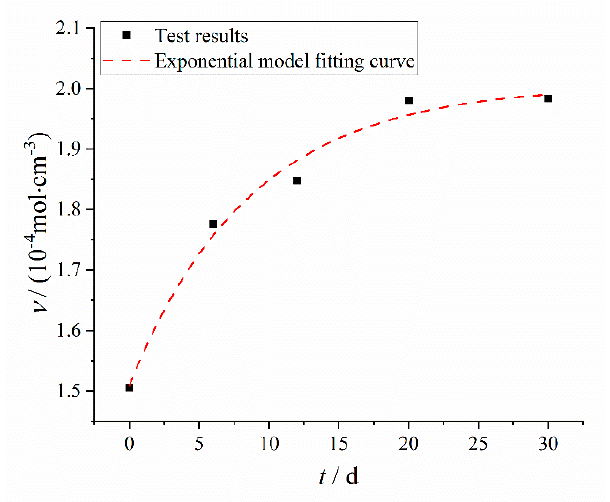
Figure 3. Changing results and fitting curve of crosslinking density with aging time.